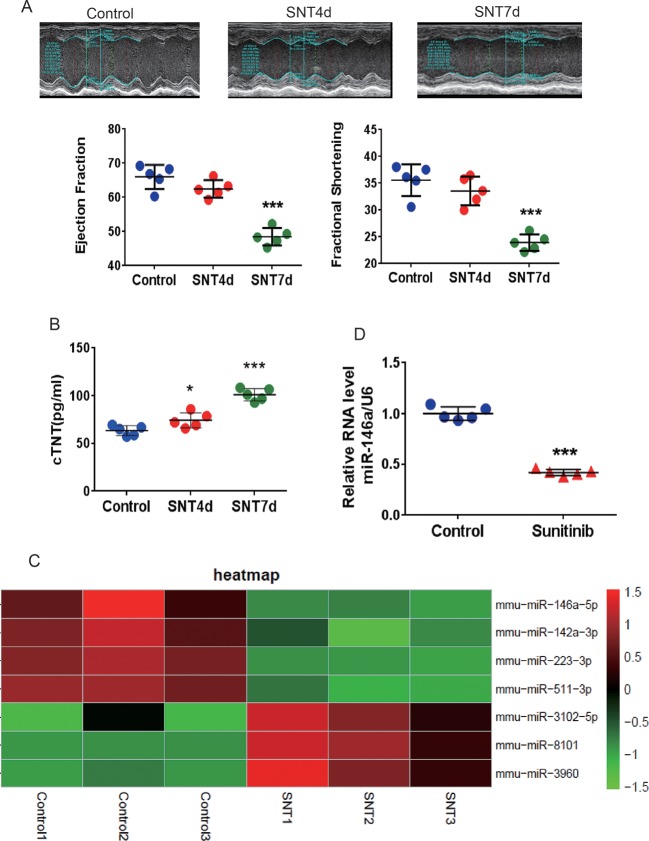
SNT induced cardiac contractile dysfunction and abnormal expression of miRNA. (A) For the C57mouse administered sunitinib (40 mg/kg/d), E-echocardiography showed a significant decrease in cardiac contractile function on day 7. (B) The level of the serum marker cTNT was increased after sunitinib-treatment. (C) Summary heat map of differences in miRNA expression in the left ventricle tissue of mice 7 days after sunitinib administration. (D) RT-qPCR results showing that sunitinib induced the downregulation of miR-146a. Values are normalized to the level of U6. *P < 0.05, ***P < 0.001 vs Control.